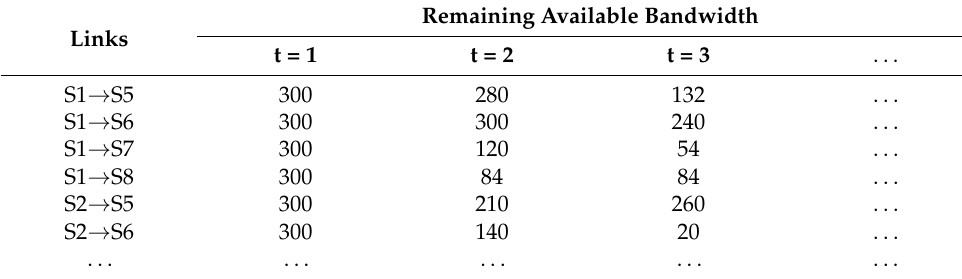
Table 1. Remaining bandwidth table.